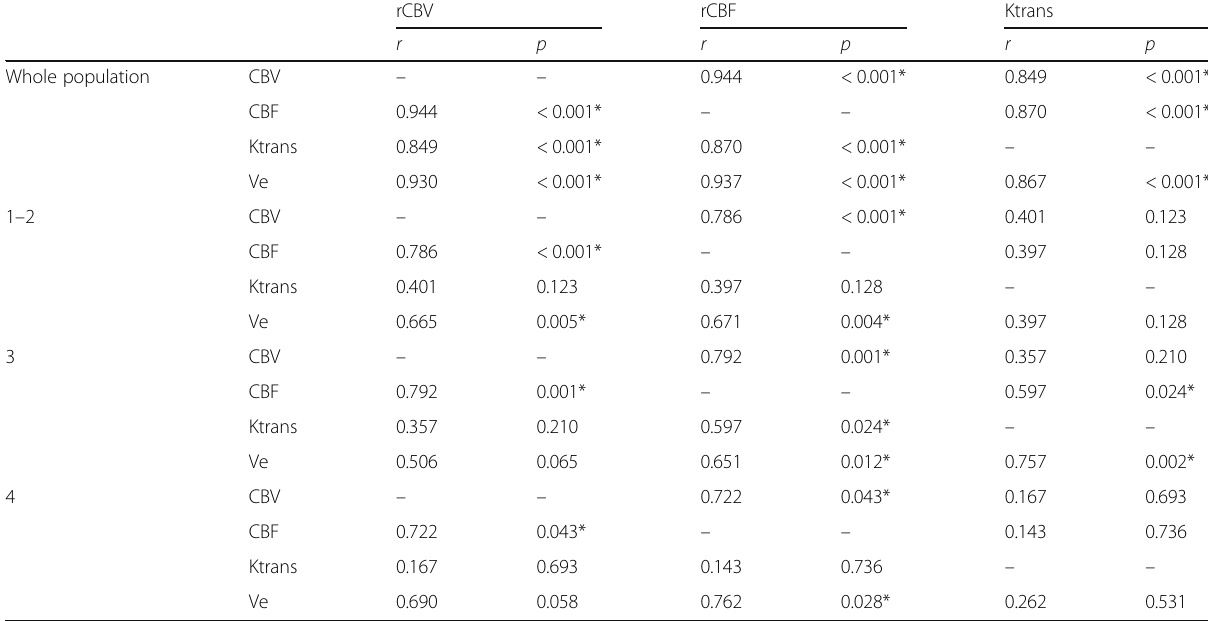
Table 3 Correlations between variables in the whole population and grade